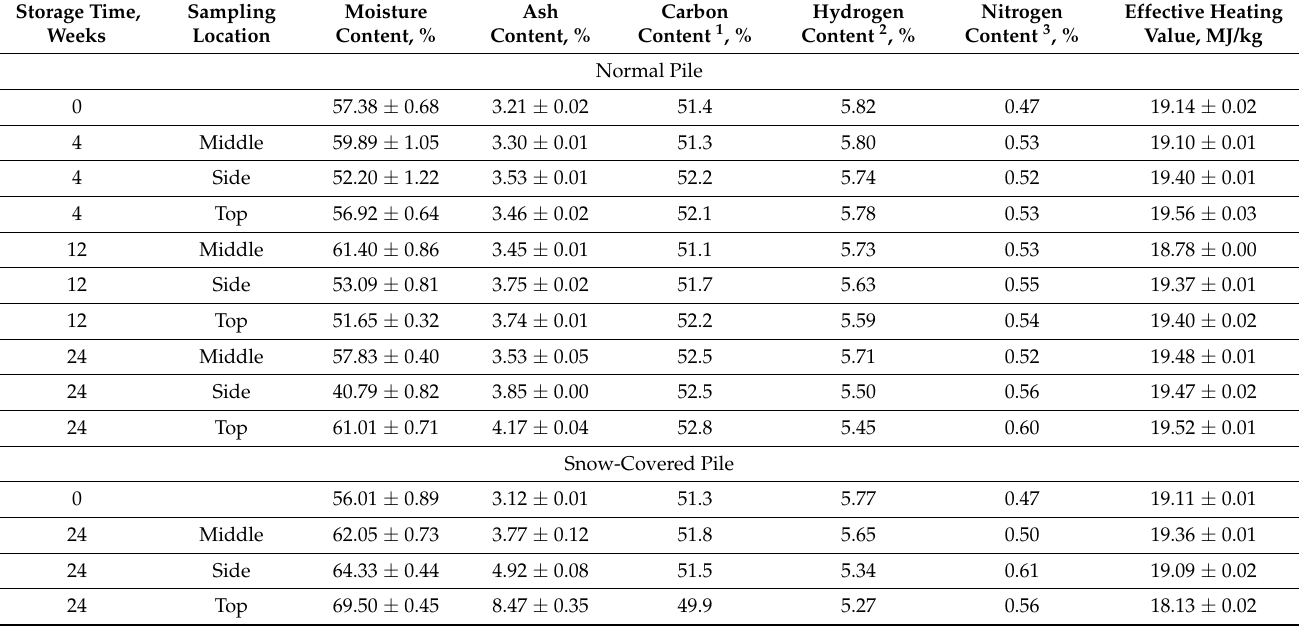
Table 2. Moisture, ash, carbon, hydrogen and nitrogen content of the studied bark samples and their effective heating